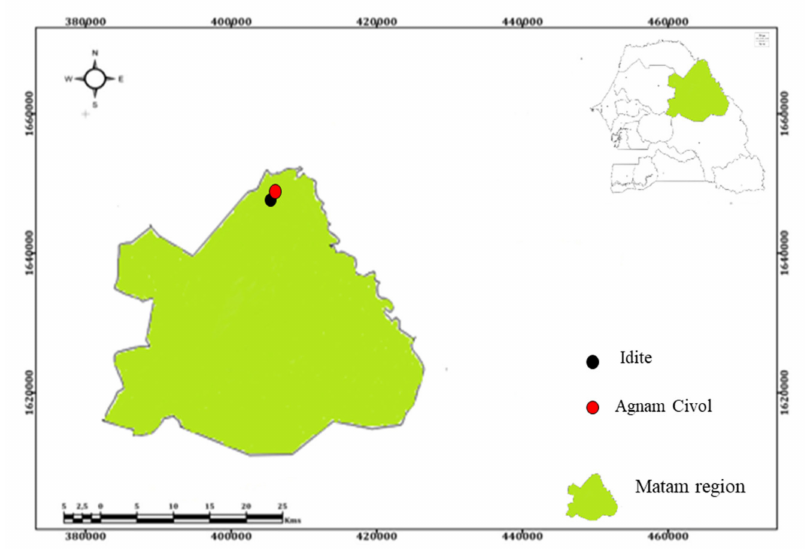
Figure 1. Study Areas: Agnam Civol health care center (represented by the red dot) for human sampling and Idite (represented by the black dot) for sheep and tick sampling. These areas are 14.8 km apart and are located in the Agnam district in the region of Matam (colored in green) in the Northern